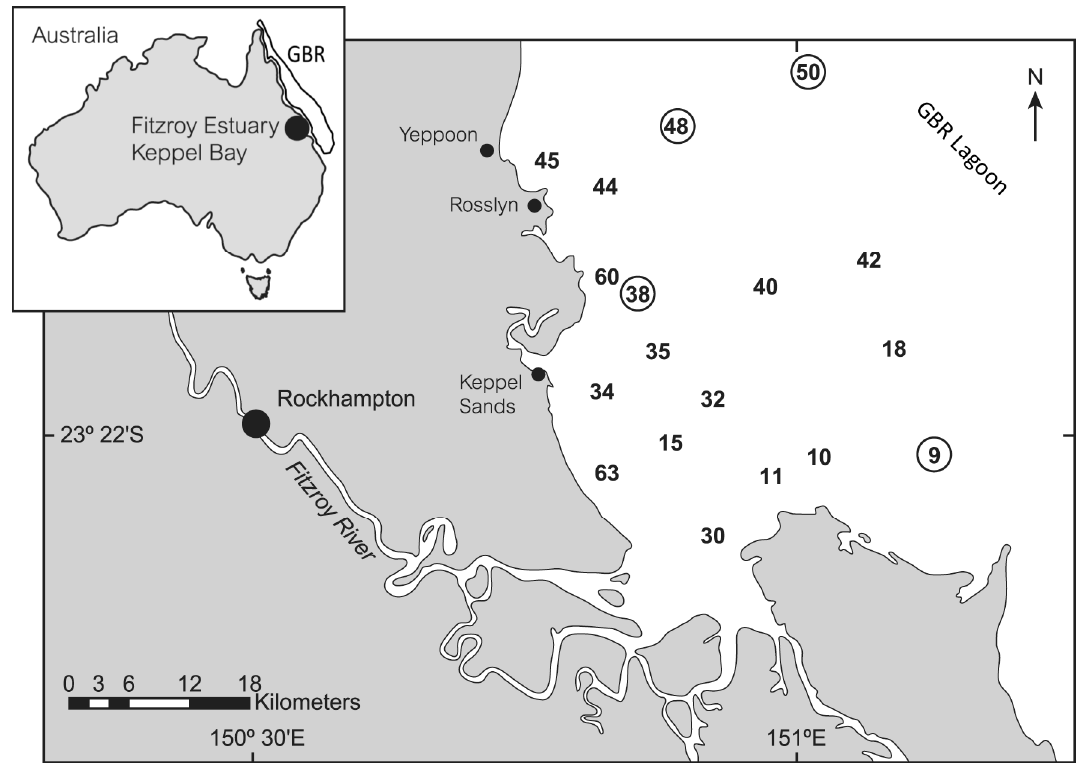
Figure 1. Map of the Keppel Bay–Fitzroy River Estuary. Numbers indicate sampling sites and circled numbers indicate sites where UV-absorption peaks were present in the CDOM fraction.